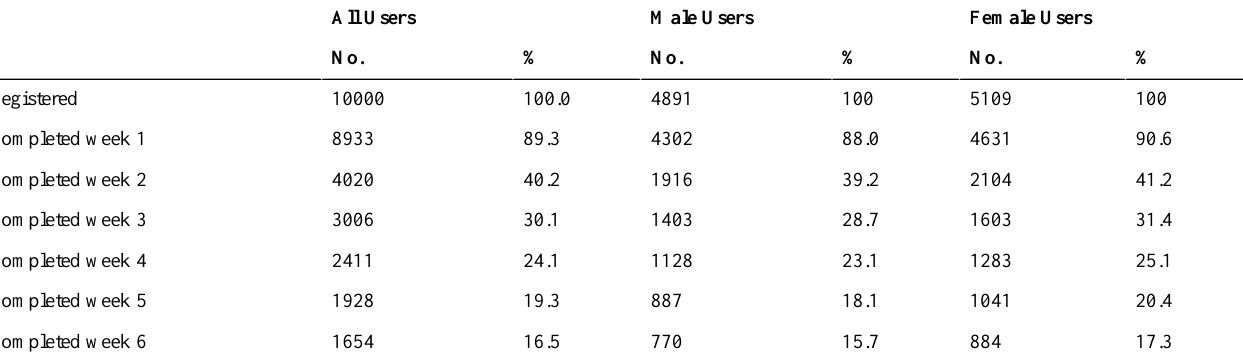
Table 2. Number of users completing each week of the program. Percentages are the proportion of those registered, for example, 16.5% of all users that registered with Down Your Drink had completed the 6-week program by the time of the data extraction (March 1, 2006).